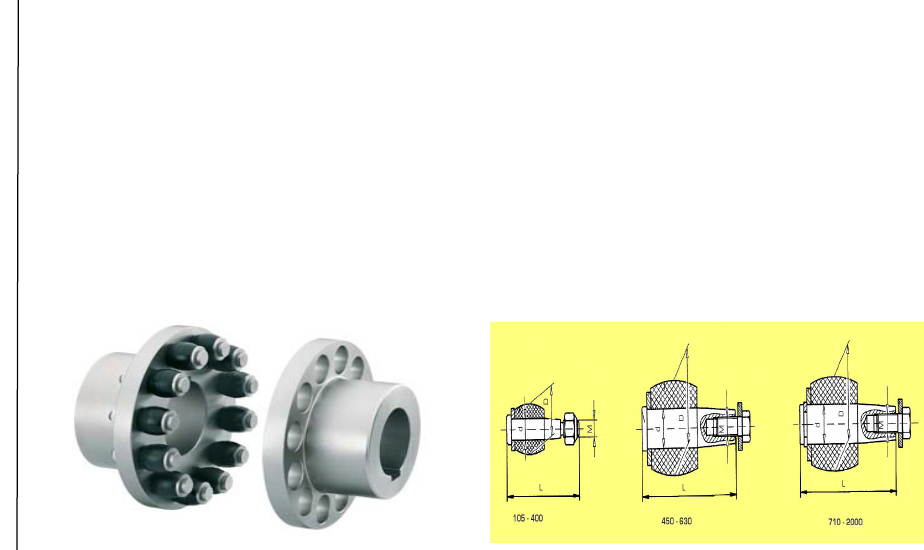
Figure 15 – Set of a flexible coupling type RWN version Flender RUPEX 710